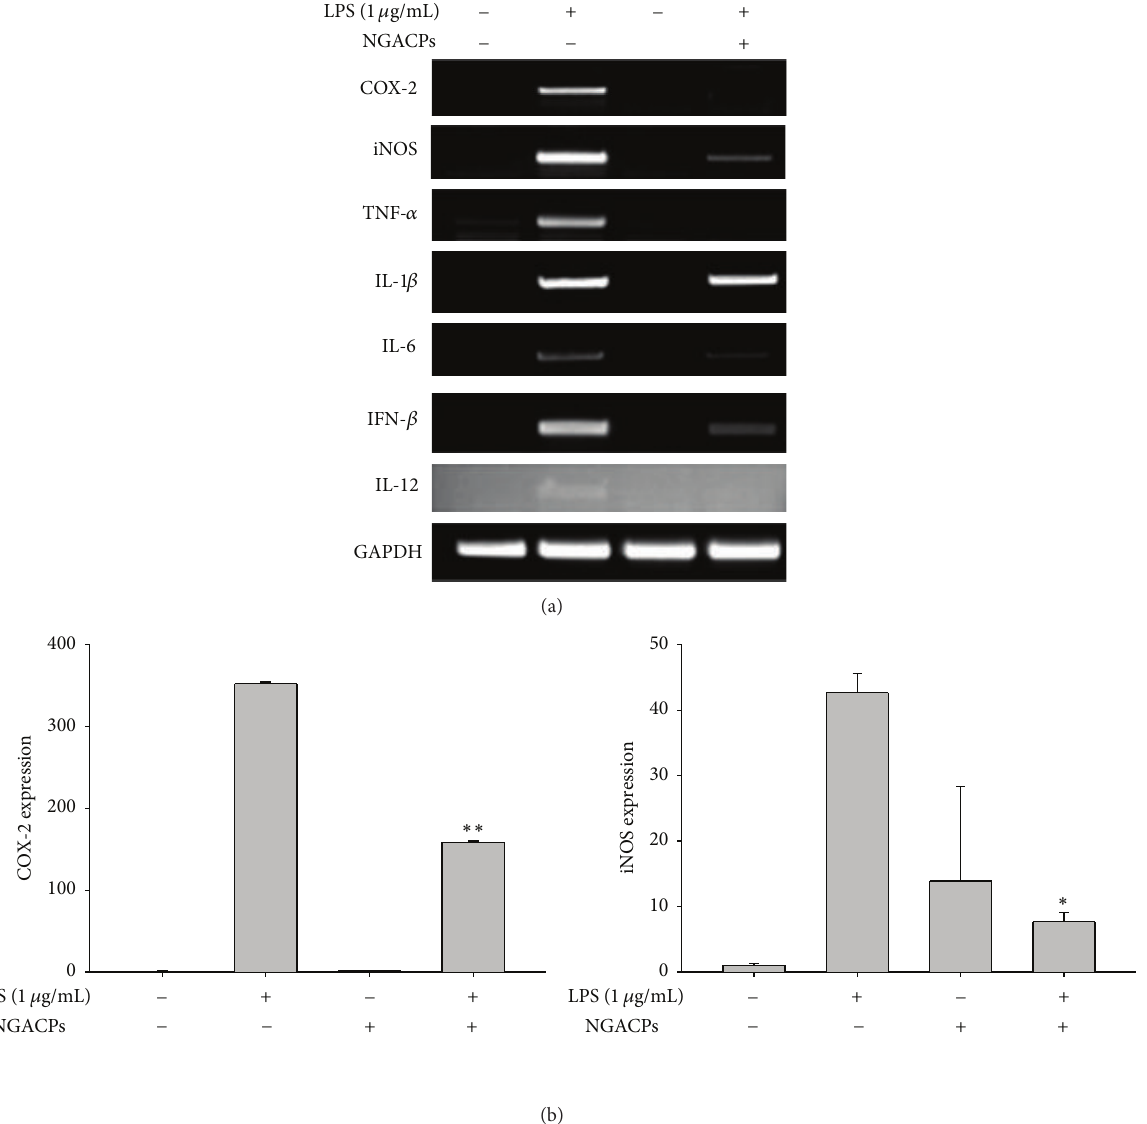
Figure 3: Effect of NGACP treatment on the expression of proinflammatory mRNA. ((a) and (b)) The mRNA levels of proinflammatory genes (COX-2, iNOS, TNF- 𝛼 , IL-1 𝛽 , IL-6, IFN- 𝛽 , and IL-12) were determined using semiquantitative RT-PCR or real-time PCR. ∗ P < 0.05 and ∗∗ P < 0.01 compared to